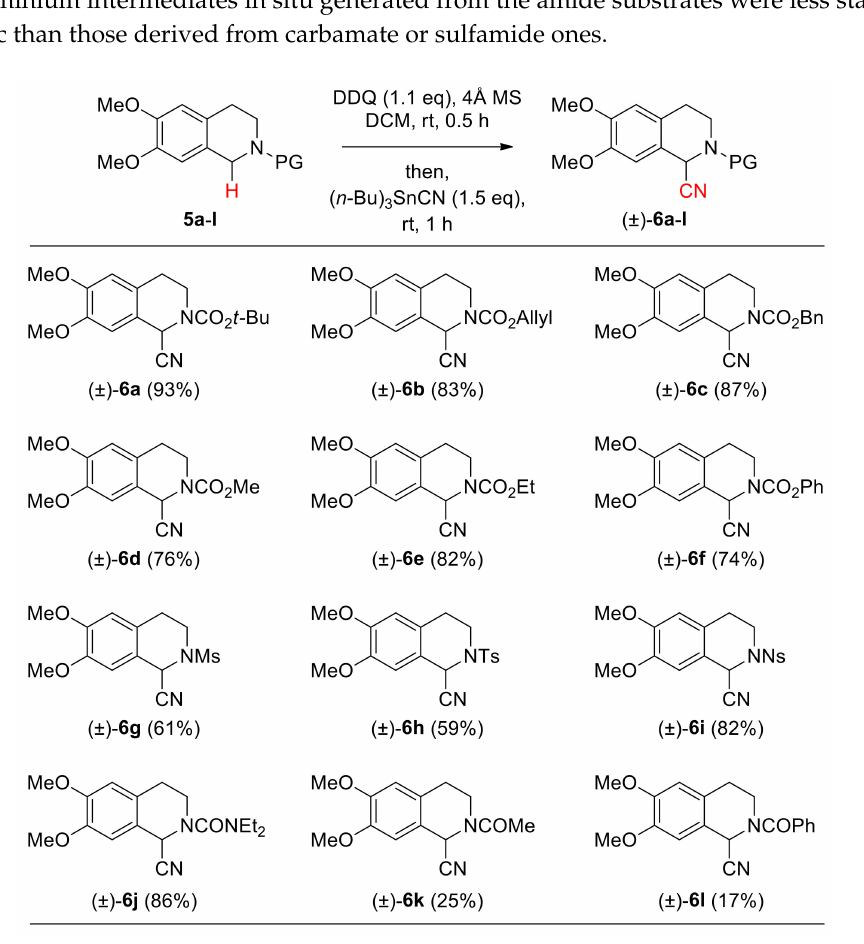
Figure 2. Reaction scope with various N -acyl/sulfonyl groups of THIQs a,b . a Reaction conditions: N -Acyl/Sulfonyl-THIQ 5a - l (0.3 mmol, 1 equivalent), DDQ (1.1 equivalent) in DCM (3.0 mL) at room temperature under an argon atmosphere for 0.5 h, then (n-Bu) 3 SnCN (1.5 equivalent) for 1 h. b Based on the isolated product using chromatography after